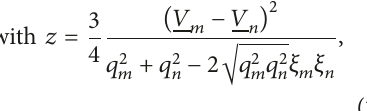
where 𝑑 𝑚 and 𝑑 𝑛 , 𝑛 𝑚 and 𝑛 𝑛 , 𝑞 2 𝑚 and 𝑞 2 𝑛 , and 𝜉 𝑚 and 𝜉 𝑛 are, respectively, the diameter, the number concentration, correlation coefficient of sections 𝑚 and 𝑛 . 𝑔 0 is the radial Simonin [30] and is equal to 1 in the